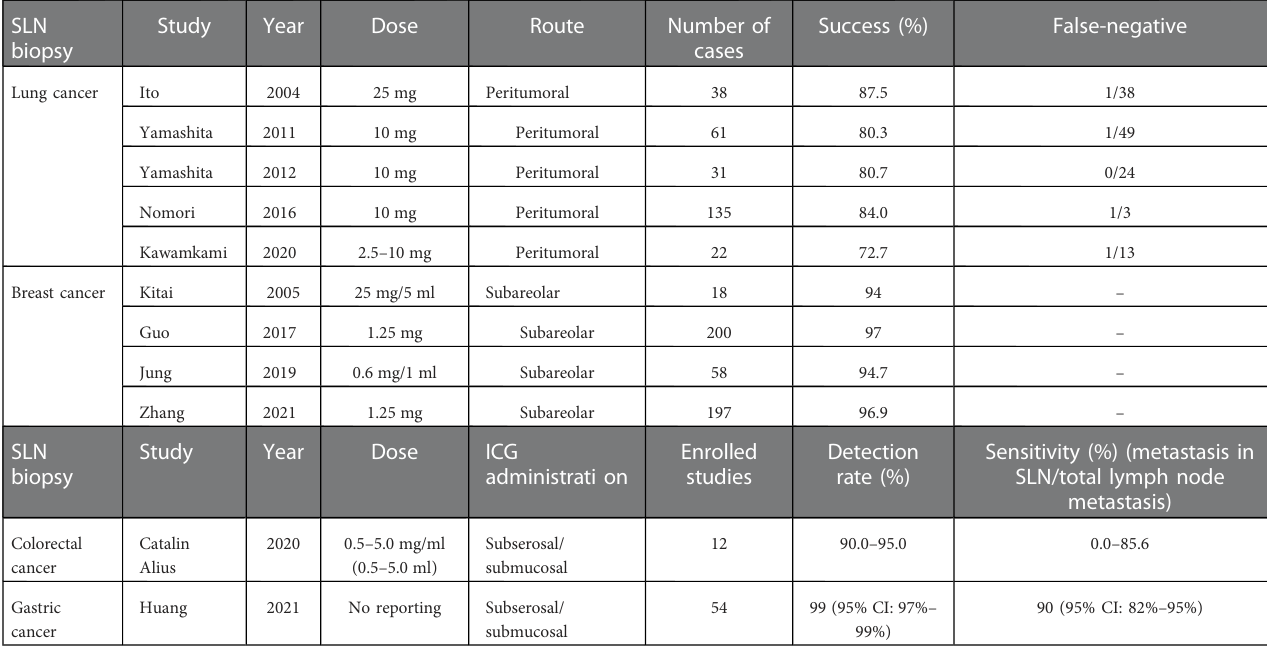
TABLE 1 Characteristics of studies evaluating the ICG technique of SLNB in different cancers. SLN